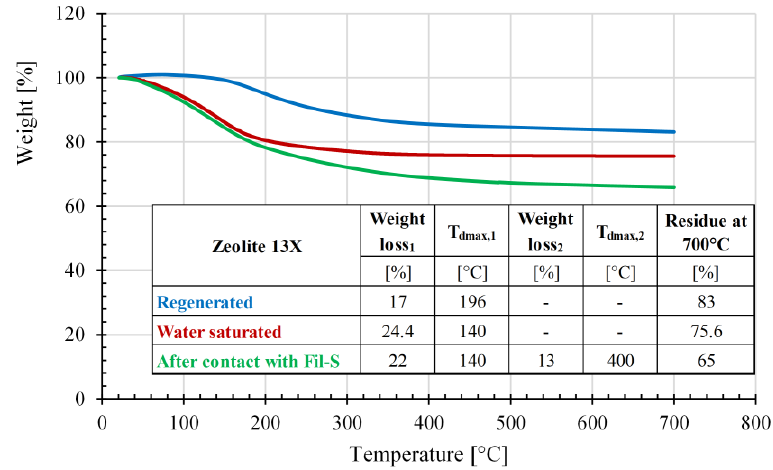
Figure 8. Results of the thermogravimetric analysis conducted on zeolite Z310 samples: after its regeneration in a muffle, water saturated and after being in contact with PW as dry blend.